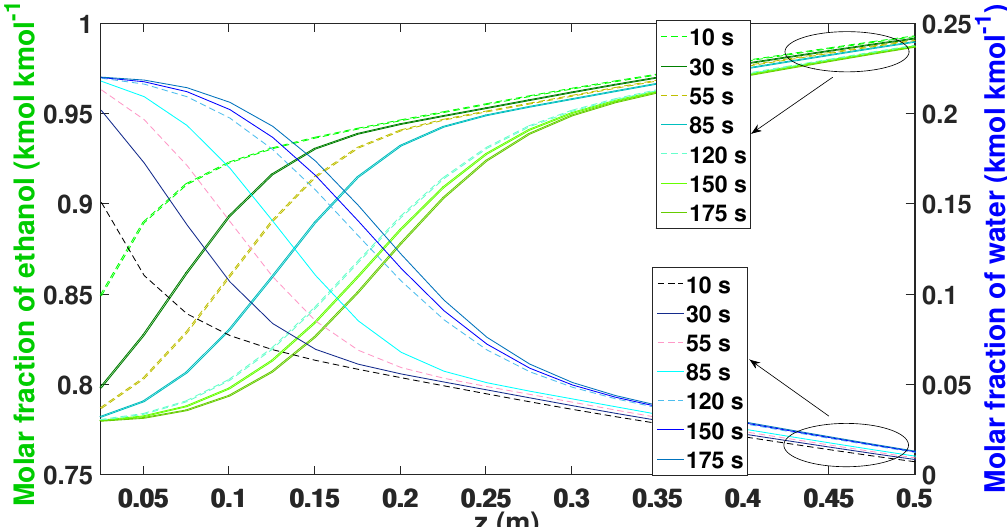
Figure 13. Molar fraction of ethanol–water during the adsorption phase while in the